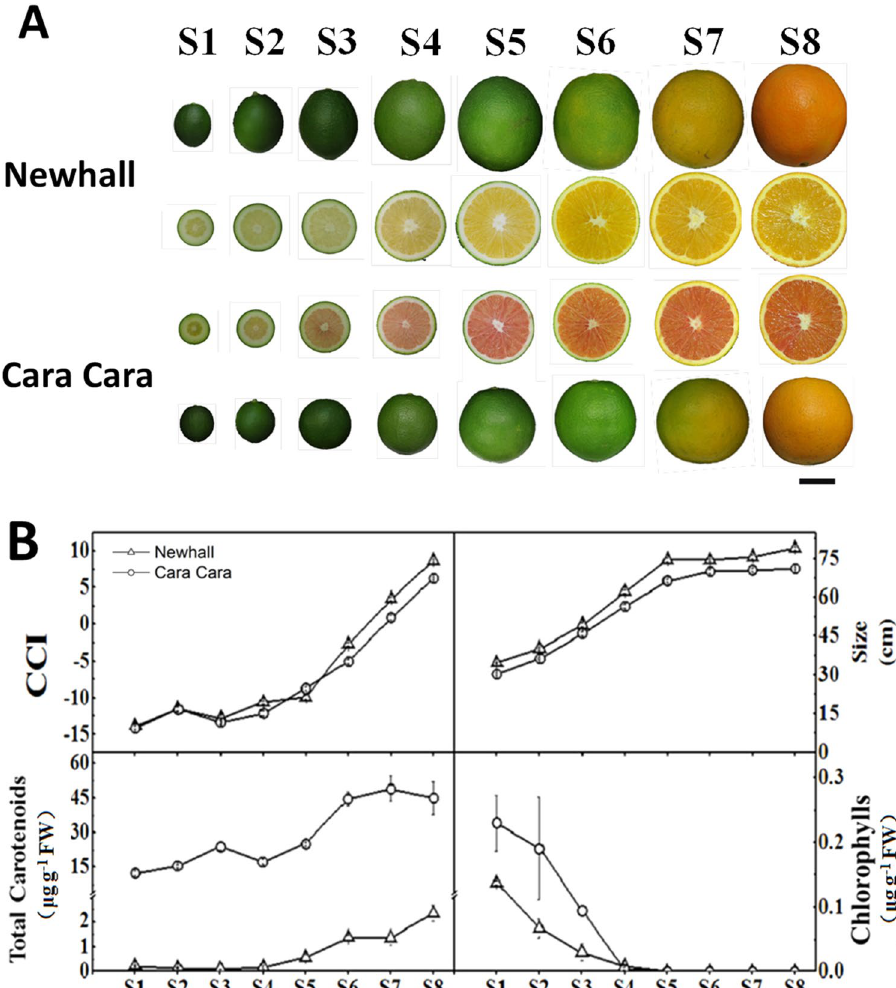
S8). Bar, 2 cm. ( B ) Changes in peel CCI (citrus colour index), fruit size (transverse diameter), content of flesh total carotenoids and flesh chlorophylls during fruit development and ripening in Newhall and Cara Cara oranges. The bars represent SE from three biological